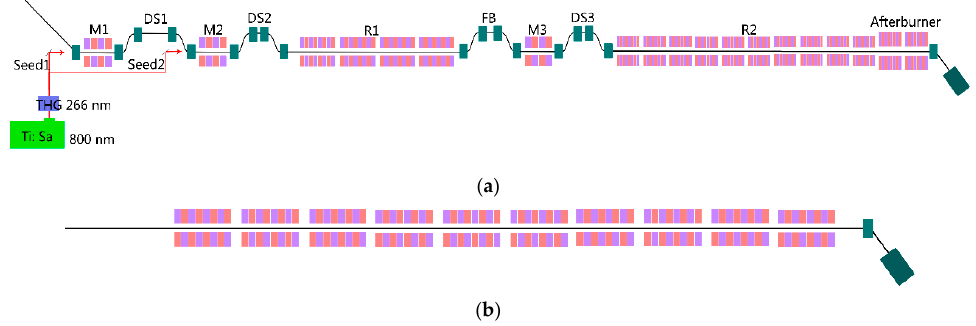
Figure 14. Schematic layout of the FEL undulator lines for the SXFEL-UF: ( a ) Seeded line of the SXFEL-UF (upgraded from SXFEL-TF); ( b ) new undulator line for the SXFEL-UF.